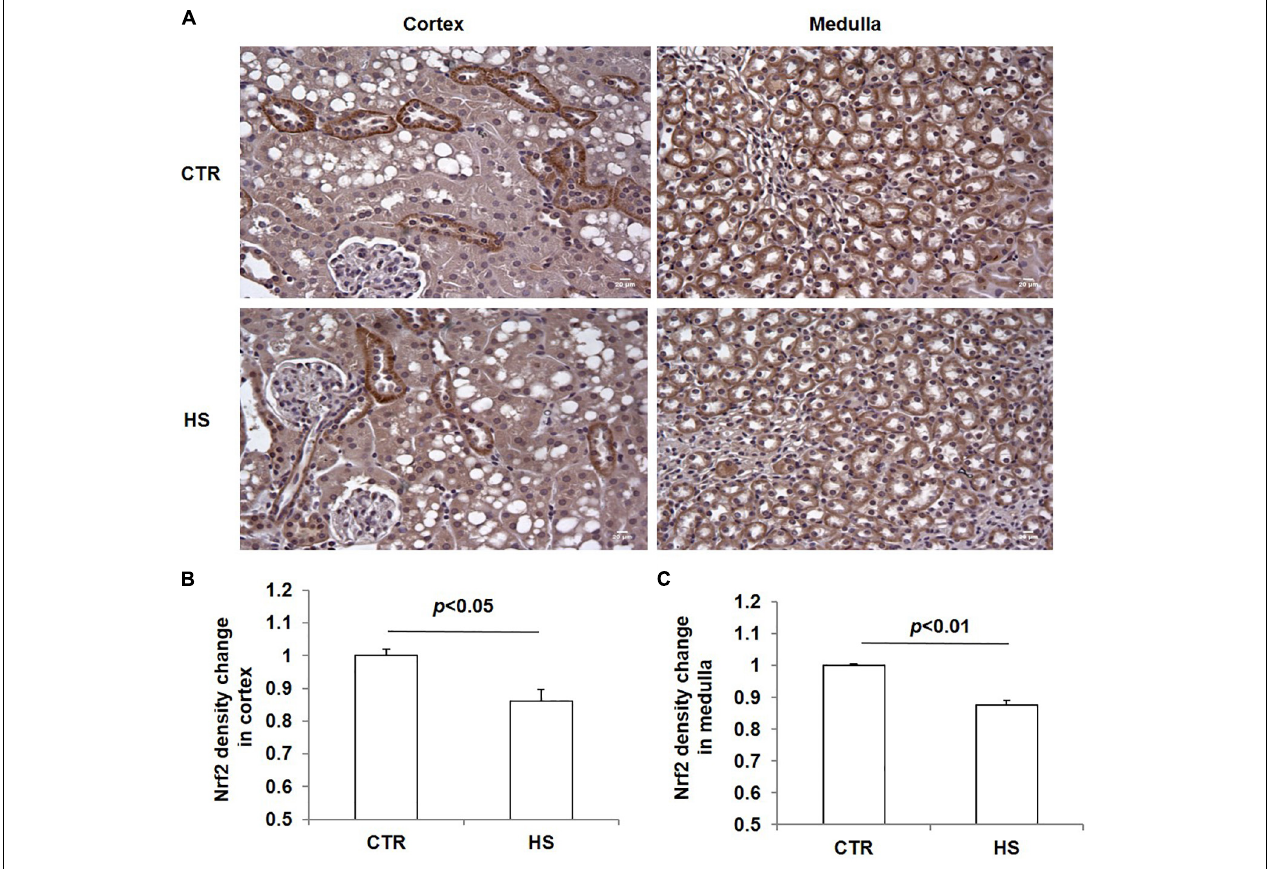
FIGURE 2 | Immunohistochemistry of Nrf2 in kidneys after acute high salt loading. (A) Immunohistochemistry of Nrf2 in renal cortex and medulla. Magnification: 400 × . Scale bar: 20 µ m. (B) Densitometric analysis of Nrf2 in renal cortex. (C) Densitometric analysis of Nrf2 in renal medulla. The presented data are means ± SE. The images shown are representative of four to five animals per